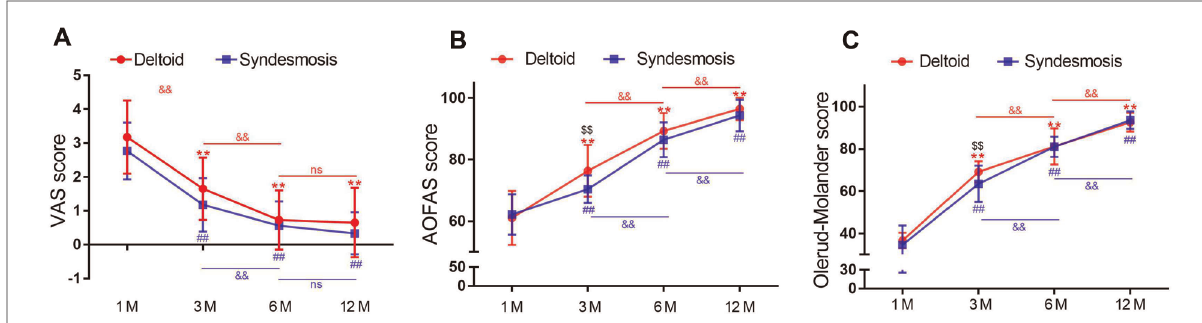
FIGURE 4 VAS ( A ), AOFAS Ankle-Hindfoot Scale ( B ), and Olerud – Molander scale ( C ) analysis from 1 to 12 months postoperatively. ANOVA: ** p <0.01 compared with 1 month group in experimental group; ## p <0.01 compared with 1 month group in control group; and && p <0.01 compared with the indicated group. Independent sample ’ s t tests: && p <0.01 compared with control group. VAS, visual analog pain scale; AOFAS, American Orthopaedic Foot and Ankle Society; ANOVA, analysis of